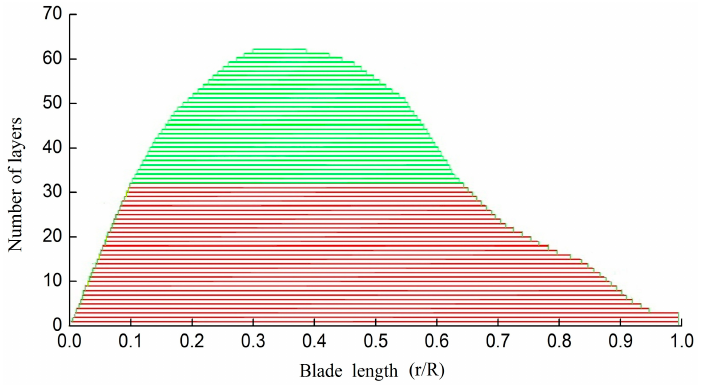
Figure 6. Material layup of the spar cap.